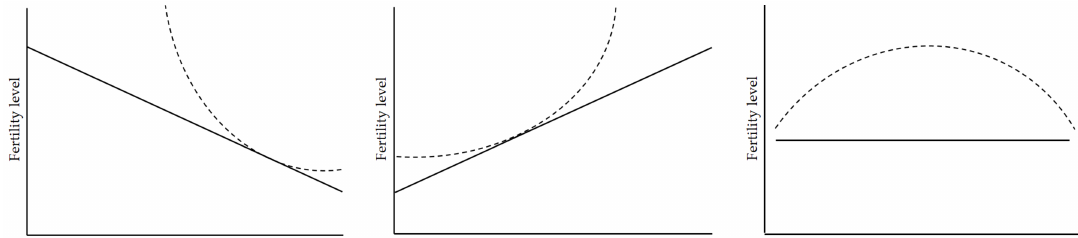
Figure 3. The assumed relationship between fertility level ( y -axis) and population density ( x -axis), distinguishing three possible configurations of linear and non-linear patterns (the right panel reflects the main assumptions of suburban